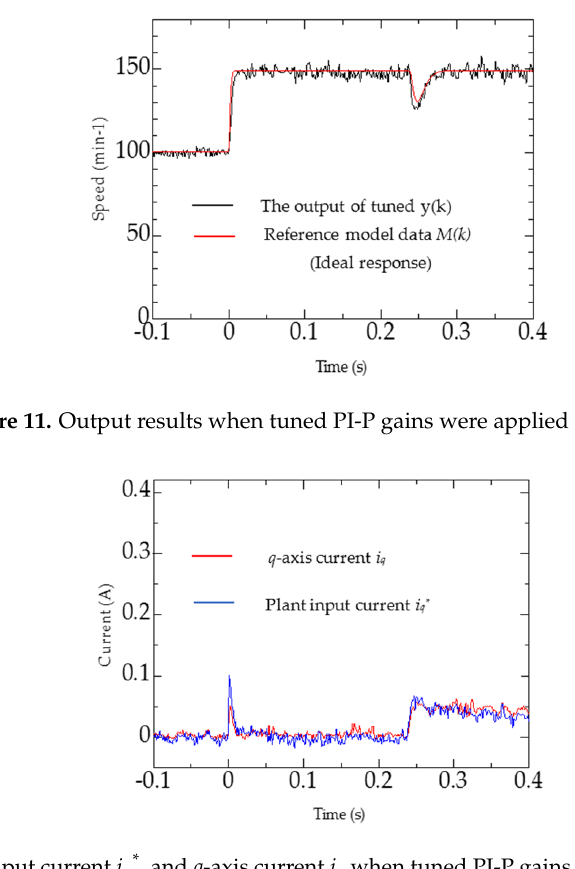
Figure 12. Plant input current i q* , and q- axis current i q when tuned PI-P gains were applied using FRIT.